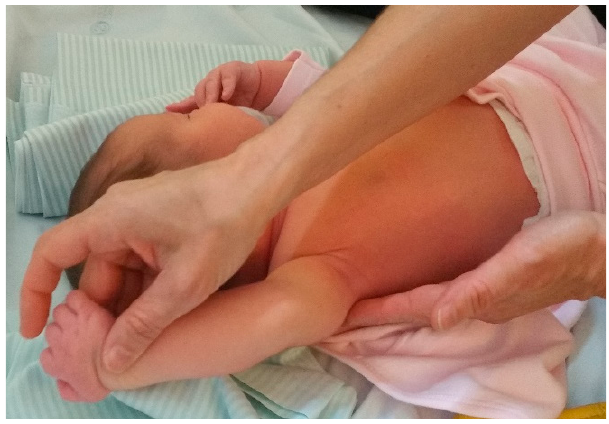
Figure 3. Passive mobilisation of shoulder flexion, with scapula support.